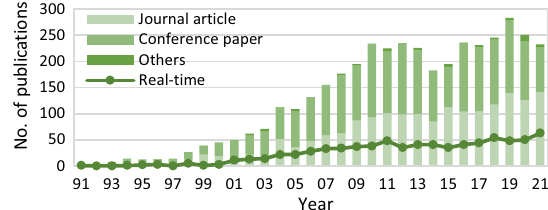
Fig. 5 Evolution over time of the number of publications per type related to the detection and classification of PQDs